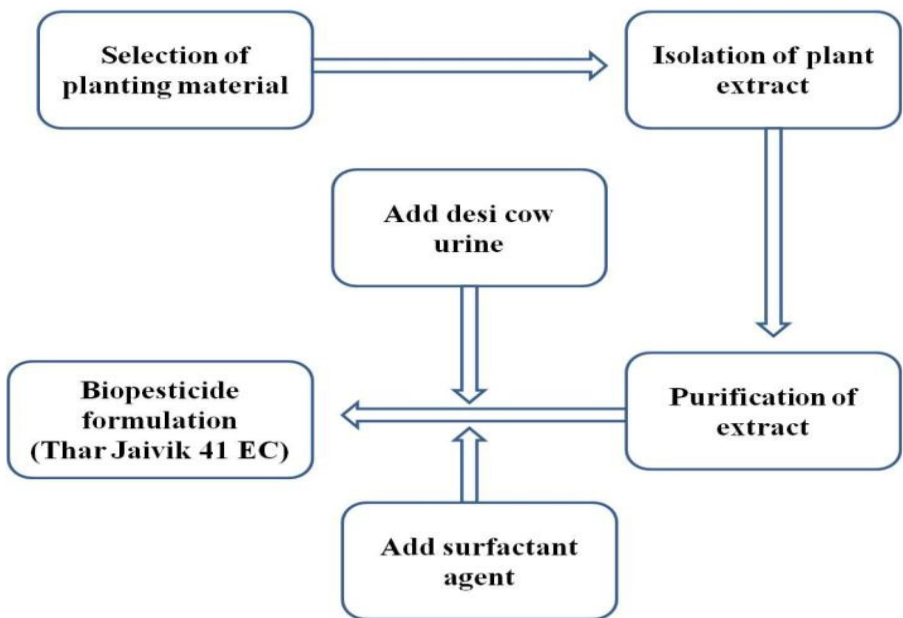
Figure 1. Diagrammatic depiction of the simplified flow chart for isolation and formulation of biopesticide “Thar Jaivik 41 EC”.